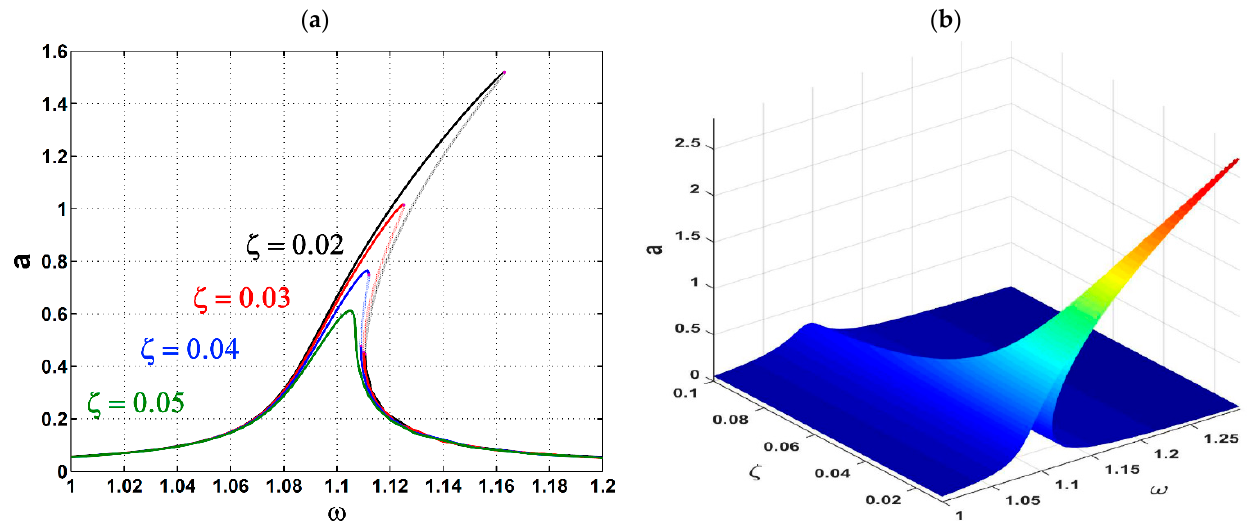
Figure 4. Relationship between the car’s oscillation amplitude a and ( a ) the excitation frequency ω at different values of damping factor ζ , ( b ) both the excitation frequency ω and damping factor ζ , at k = 7 and β = 0.8 pre-control ( k p = k v =